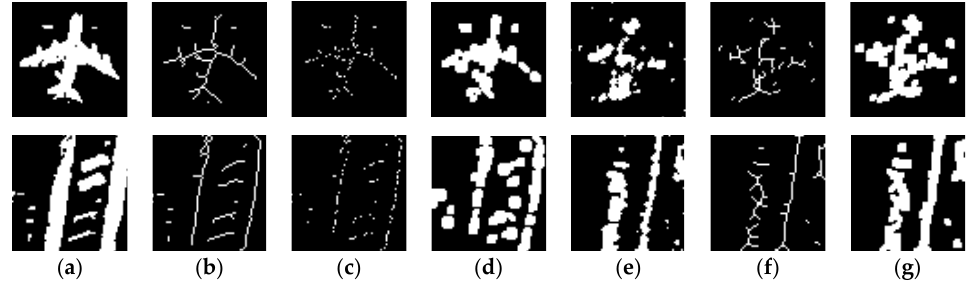
Figure 9. The slices in feature association steps. ( a ) is the binarization of optical images; ( b ) is the